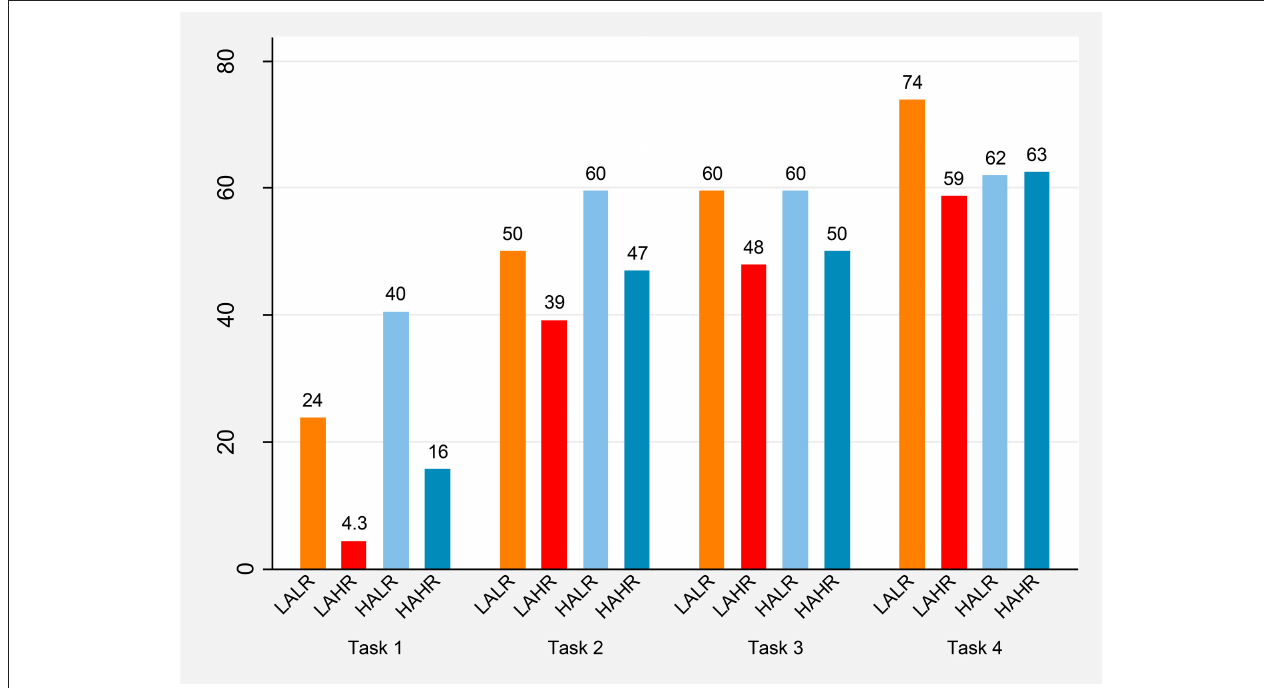
FIGURE 5 | Percentage of individuals cooperating in period 1 of each